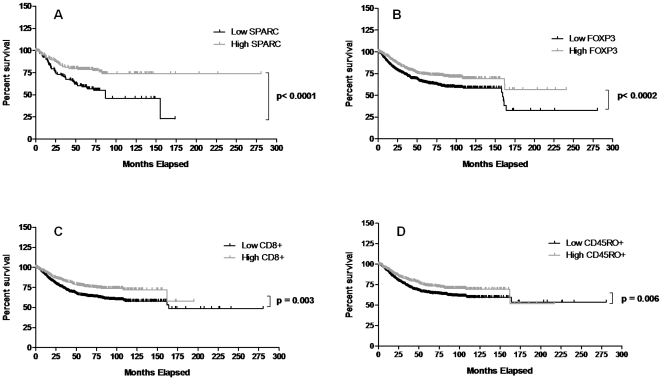
Overall survival.Kaplan-Meier survival curves were derived to show high and low marker levels in relation to survival. (A) High SPARC levels significantly correlated with better long-term survival. (B) High FOXP3 levels also significantly correlated with better long-term survival. Although high (C) CD8 and (D) CD45RO expression levels were associated with better long-term survival, the separation and significance between the curves were not as great.